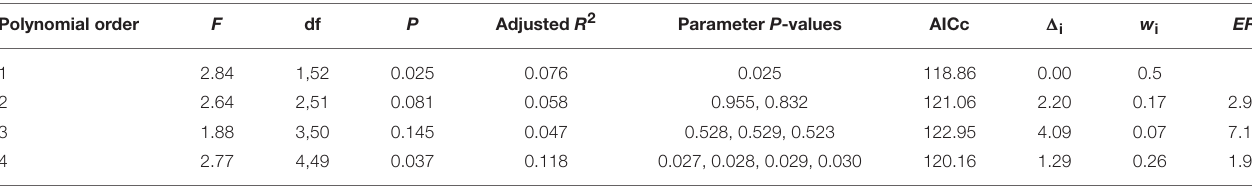
TABLE 5 | Summary of 4 candidate models with different polynomial order assessing the effects of wing loading on the frequency of bird strikes following different criteria: F and P values, Akaike’s Information Criterion (corrected for sample size, AIC c ), AICc difference ( 1 i), Akaike weight (w i ), and Evidence Ratio (ER). Polynomial order